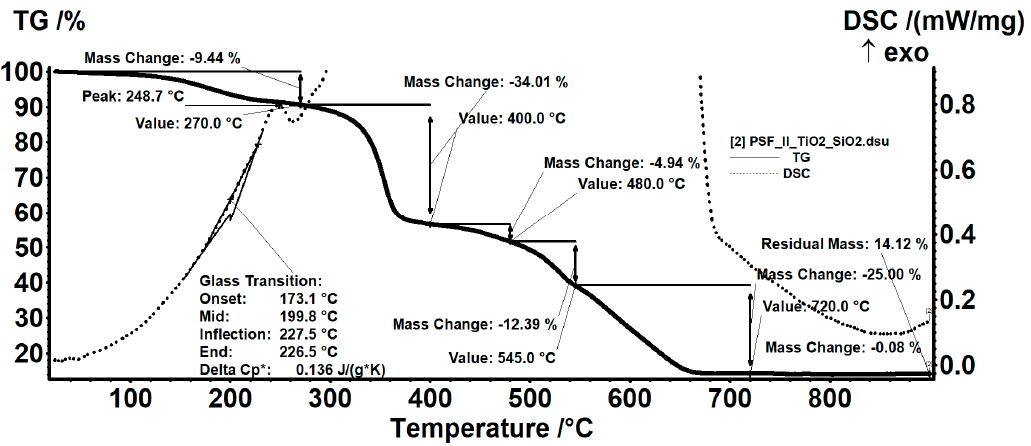
Figure 8. TGA curve for polysulfone-SiO 2 -TiO 2 composite membrane.